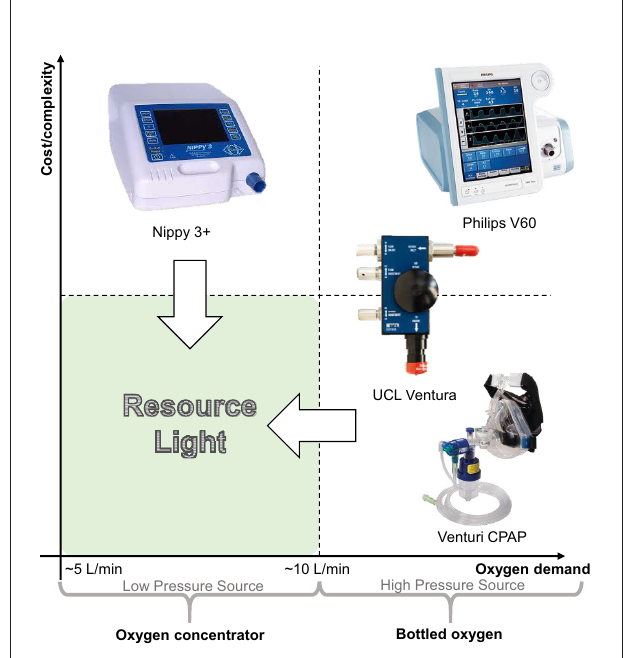
FIGURE 1 | Comparison of non-invasive ventilation options for delivering CPAP arranged into quadrants according to their relative cost/complexity and use of oxygen. The “resource light” quadrant (lower left) highlights the need for systems which are both mechanically simple and can operate sustainably using an oxygen concentrator with typical output flowrates